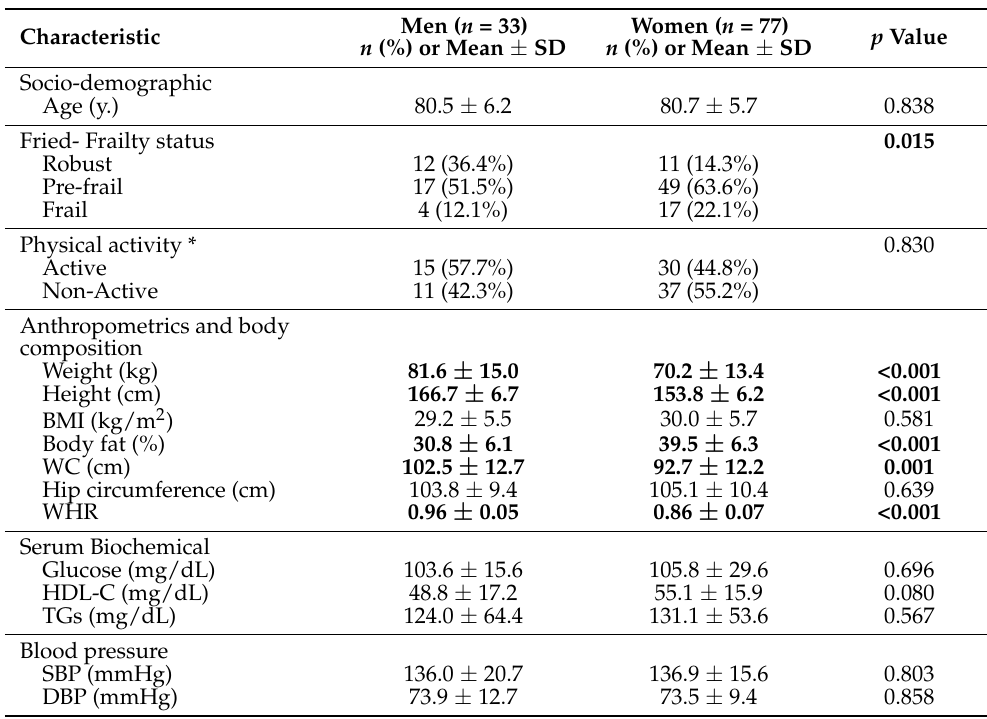
Table 2. Socio-demographic, frailty status, physical activity, anthropometrics and body composition, and blood serum biochemical and blood pressure characteristics of the